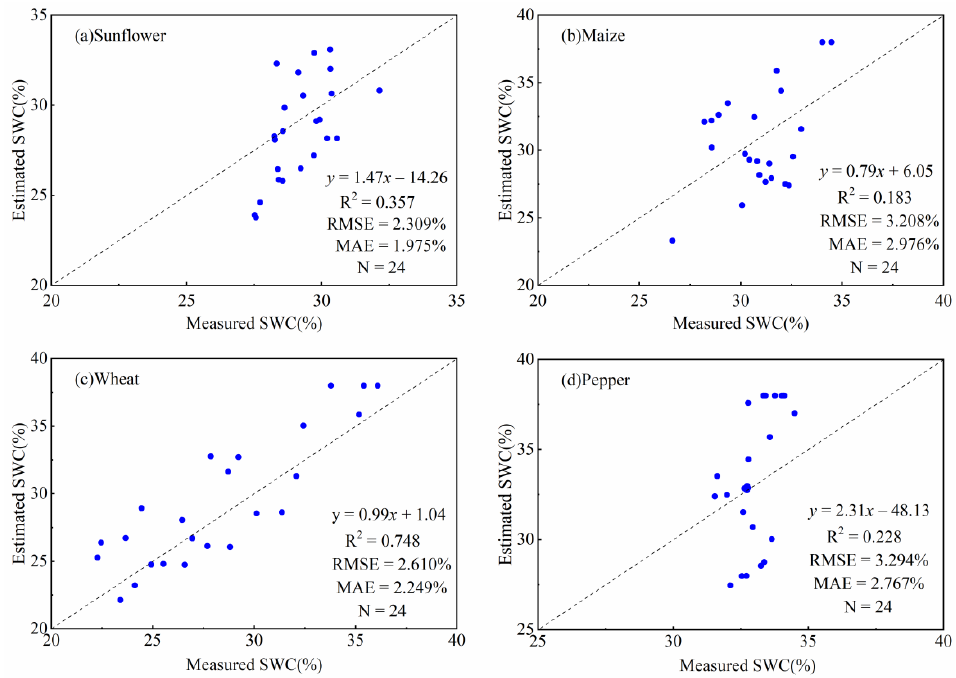
Figure 8. Scatter plot of the estimated SWC compared with the measured SWC. ( a ) Sunflower; ( b ) Maize; ( c )Wheat; ( d ) Pepper.